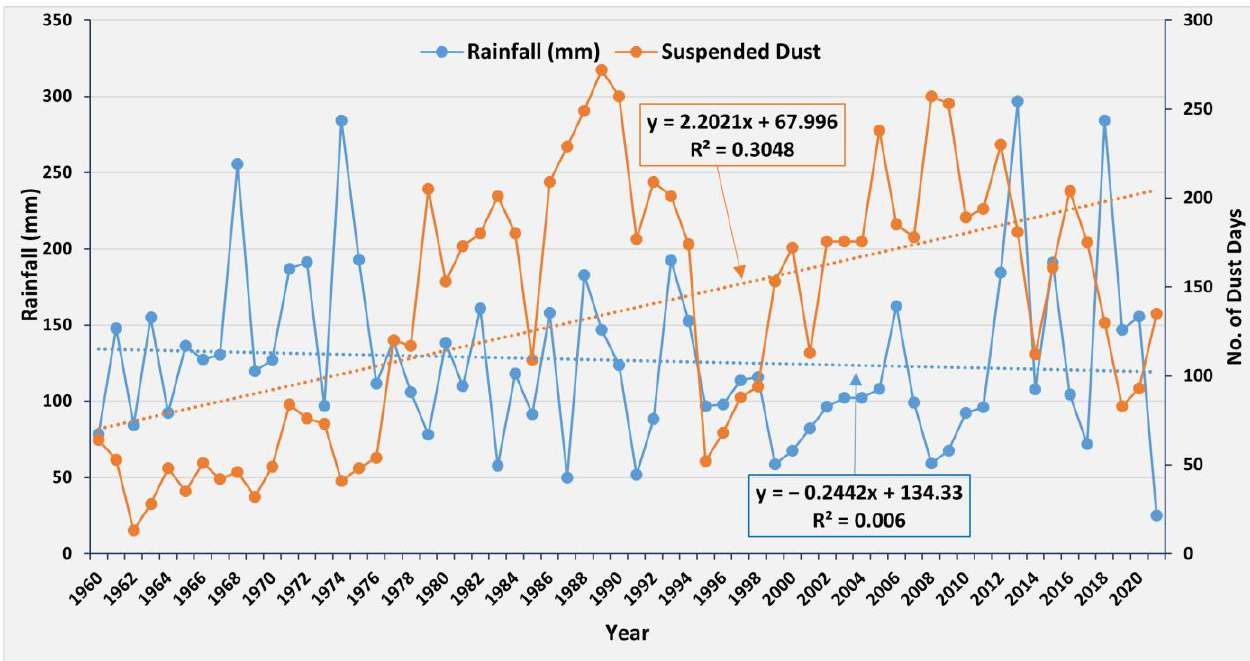
Figure 6. Total rainfall and number of SDSs from 1960 to 2021. ࡉ